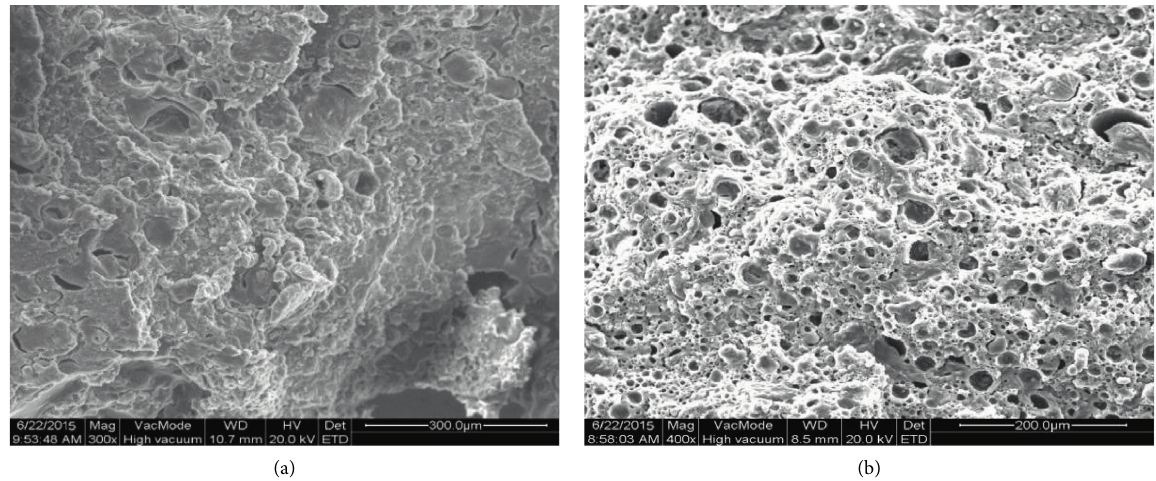
Figure 22: Micromorphology of cured epoxy-emulsified asphalt: (a) Internal section; (b) Surface.